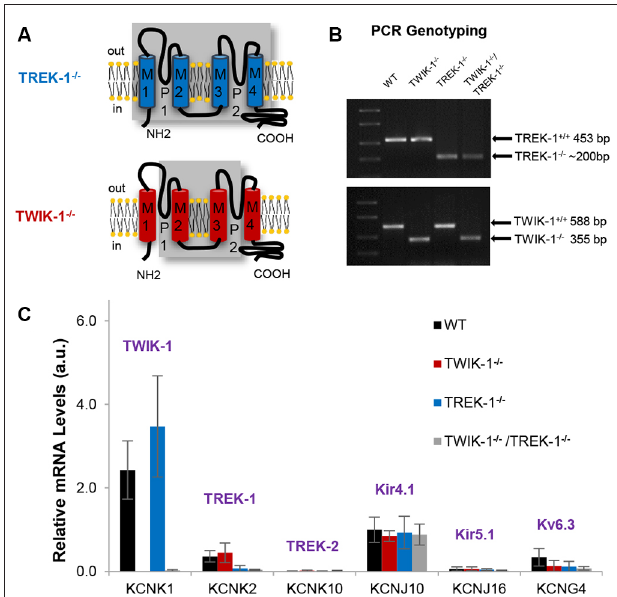
FIGURE 1 | Expression of astrocyte K + channels in TREK-1, TWIK-1 single, and TWIK-1/TREK-1 double gene knockout mice. (A) Schematic illustrations of genetic deletion of four transmembrane domains, including two pore-forming regions, in TREK-1 knockout (TREK-1 − / − , upper), and TWIK-1 knockout (TWIK-1 − / − , lower) mice. (B) PCR genotyping confirmation of successful genetic knockout of the targeted genes in TWIK-1 − / − , TREK-1 − / − , and TWIK-1/TREK-1 double knockout (TWIK-1 − / − /TREK-1 − / − ) mice. (C) The relative quantity of mRNA of K + channels in freshly dissociated mature astrocytes. The results were examined from wild type (WT), TWIK-1 − / − , TREK- 1 − / − , and TWIK-1 − / − /TREK-1 − / − astrocytes using